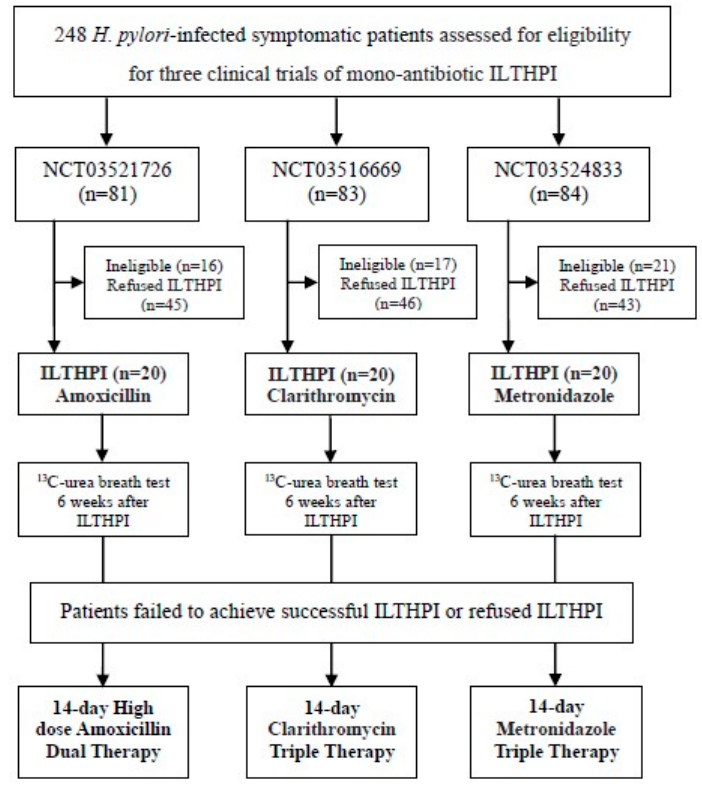
Figure 1. Study flow chart.